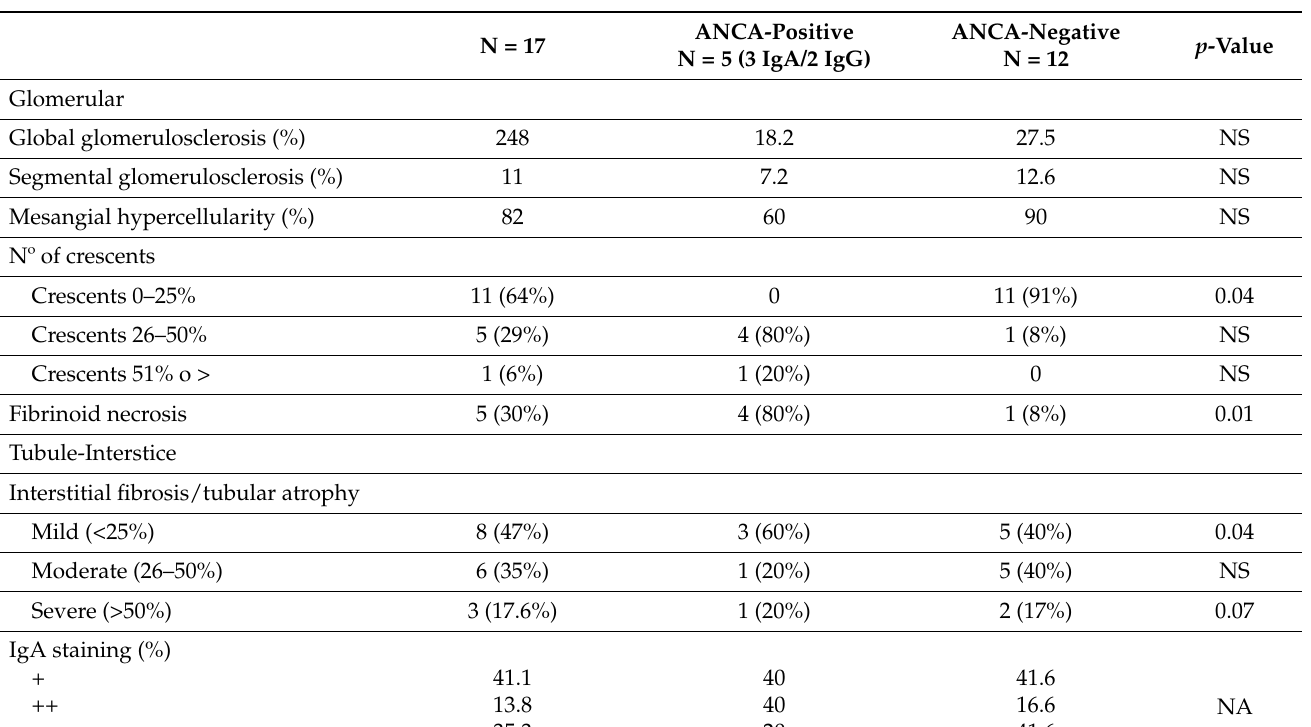
Table 3. Histologic features of patients with crescentic IgA nephropathy according to the presence or absence of